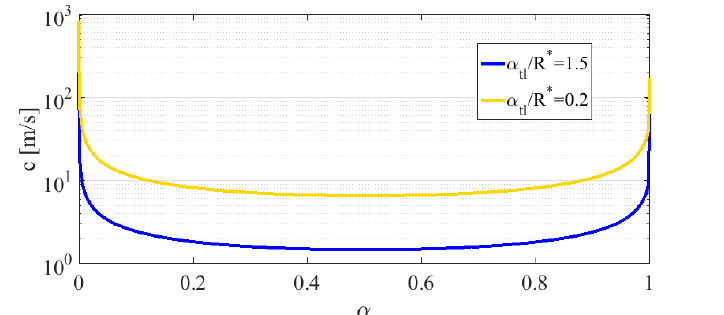
Figure 10. Speed of sound trend with the void fraction for a mixture of liquid and vapor nitrogen at √ α tl / R ∗ 77 K for two different values of